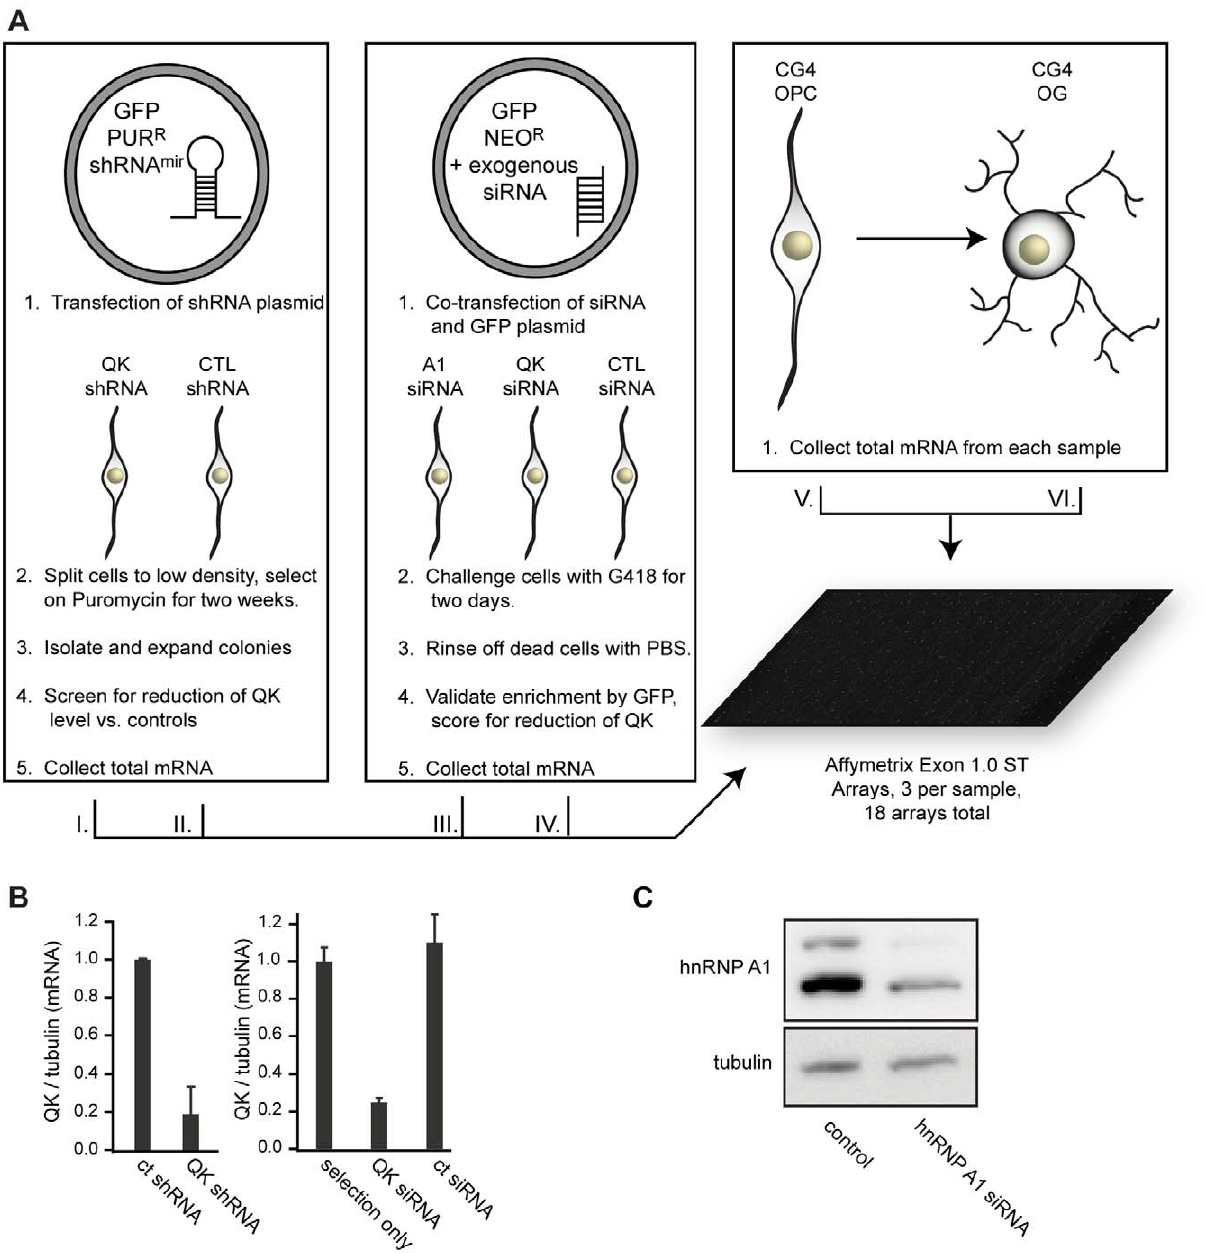
Figure 6. Microarray assay design. (A) Diagram of knockdown cell populations and controls. QK was reduced with Qk shRNA miR and Qk siRNA. hnRNP A1 was knocked down with siRNA. Control samples consisted of untransfected CG-4 cells, CG-4 cells transfected with nonsilencing siRNA, stably transfected CG-4 cells expressing a nonsilencing shRNA miR , and differentiated CG-4 cells. Each group was assayed in triplicate using three biological replicates. (B) Real time RT-PCR demonstrating QK reduction in the Qk shRNA miR stable cell line and in CG-4 cells transiently transfected with Qk siRNA. Data are the mean of three replicates + / 2 standard deviation. Error was propagated from the Qk and Tubulin standard deviations. (C) Western blot demonstrating hnRNP A1 knockdown in CG-4